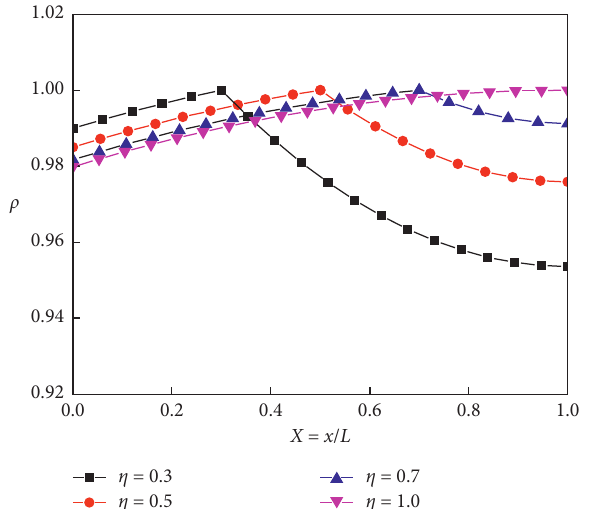
Figure 23: Effect of the interface frictional resistance at stage II on k s 2 .